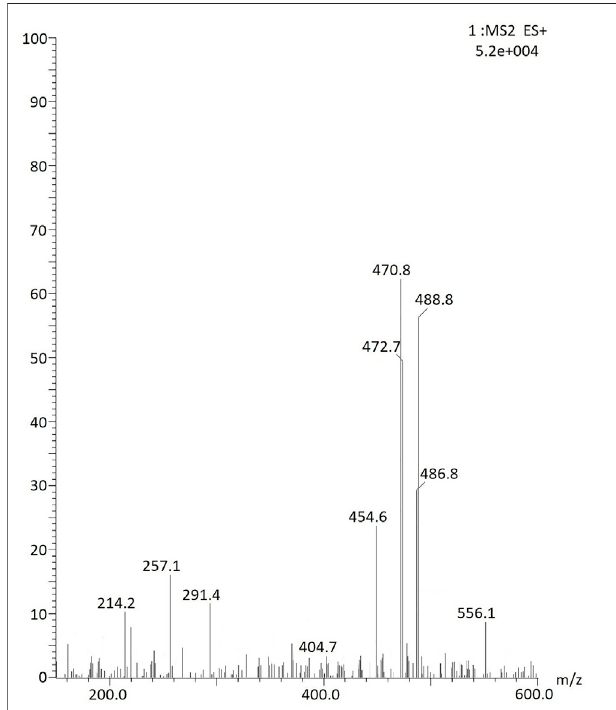
FIGURE 7 | LC-ESI/MS spectrum of WS root extract at t R 25.04